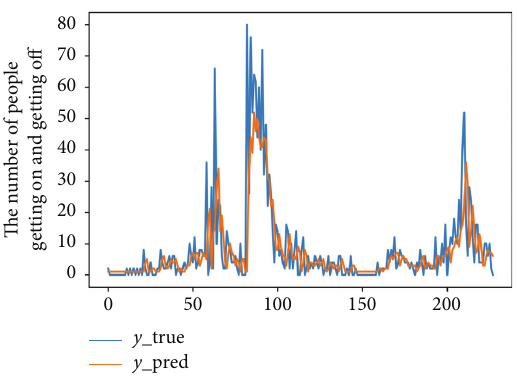
Figure 24: Regression integration prediction results when the time step is 3